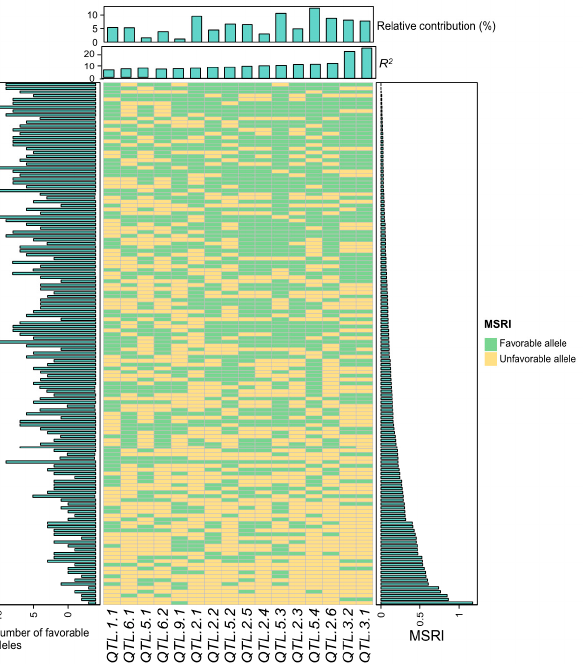
Figure 5. Relationship between the relative contributions (%) and mean R 2 of 16 quantitative trait loci (QTL).